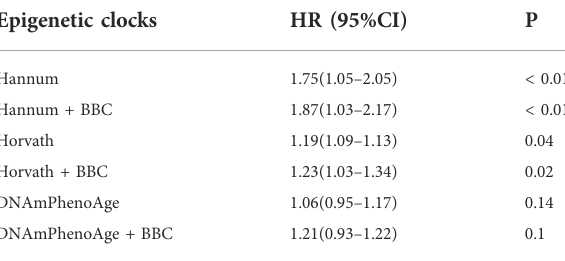
TABLE 2 Epigenetic age acceleration metrics and metformin intake using the full sample of DM patients. Epigenetic clocks